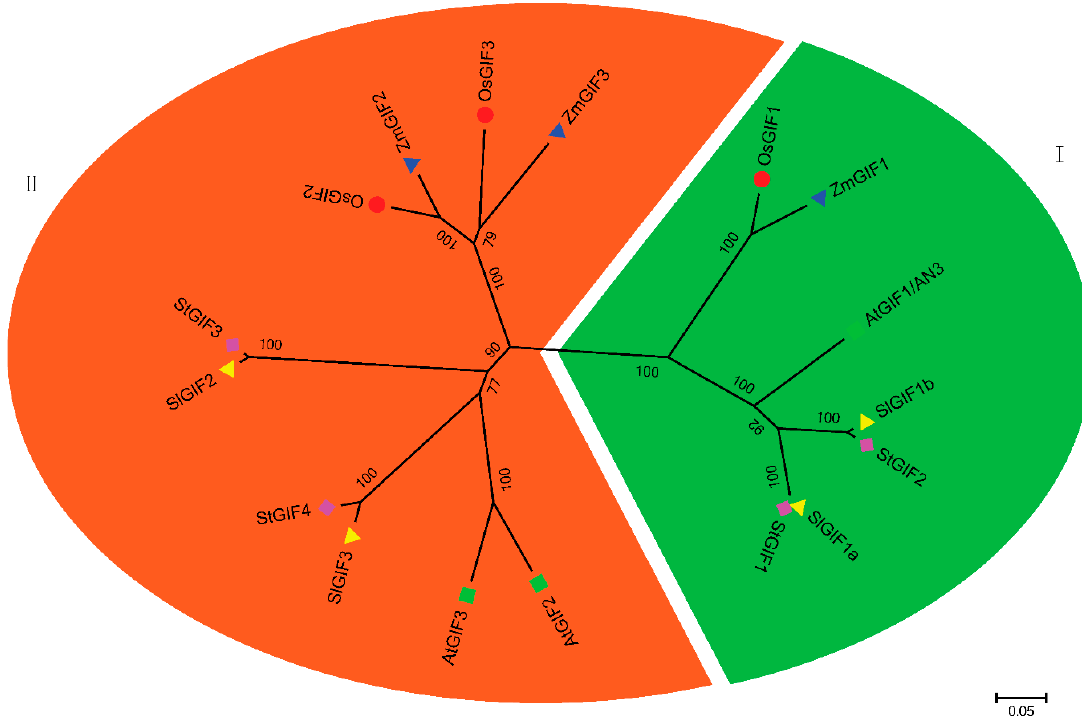
Figure 1. Phylogenetic relationship of GIF proteins. The unrooted tree was constructed using MEGA6 through the neighbor-joining method at 1000 bootstrap replicates based on the alignment of GIF protein sequences in Arabidopsis, rice, maize, potatoes, and tomatoes. The different markers before protein names stand for different plants. All these GIF proteins were clustered into two clades ( I and II ) in the phylogenetic tree.